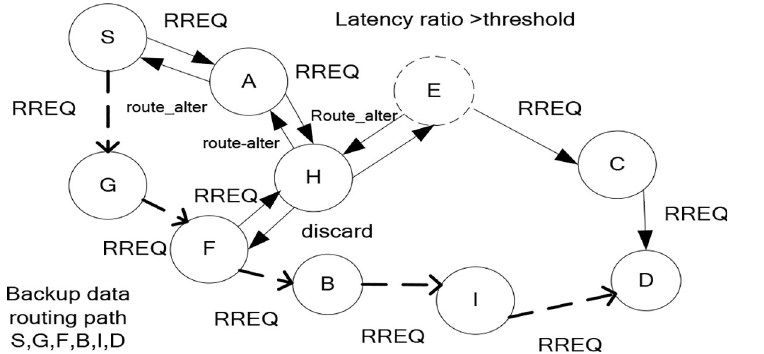
Fig 3. Re-formation of the backup routing